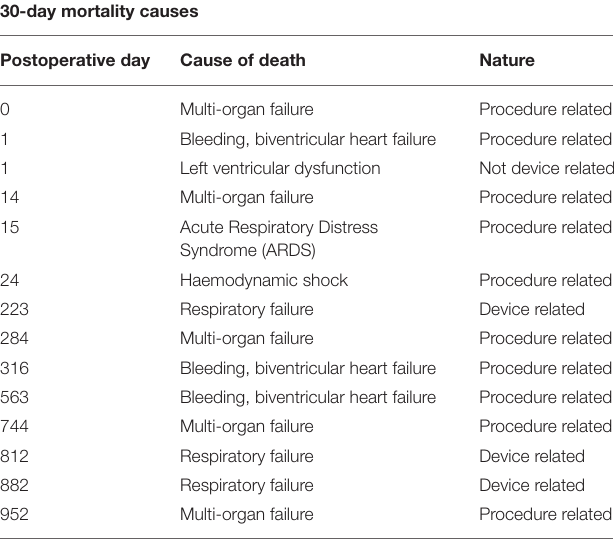
TABLE 4 | Summary of 30-day mortality